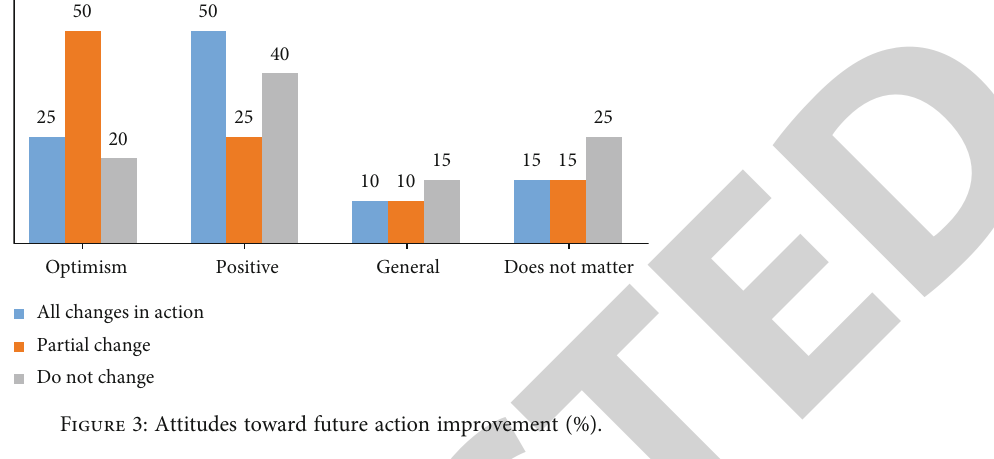
Figure 3: Attitudes toward future action improvement (%).